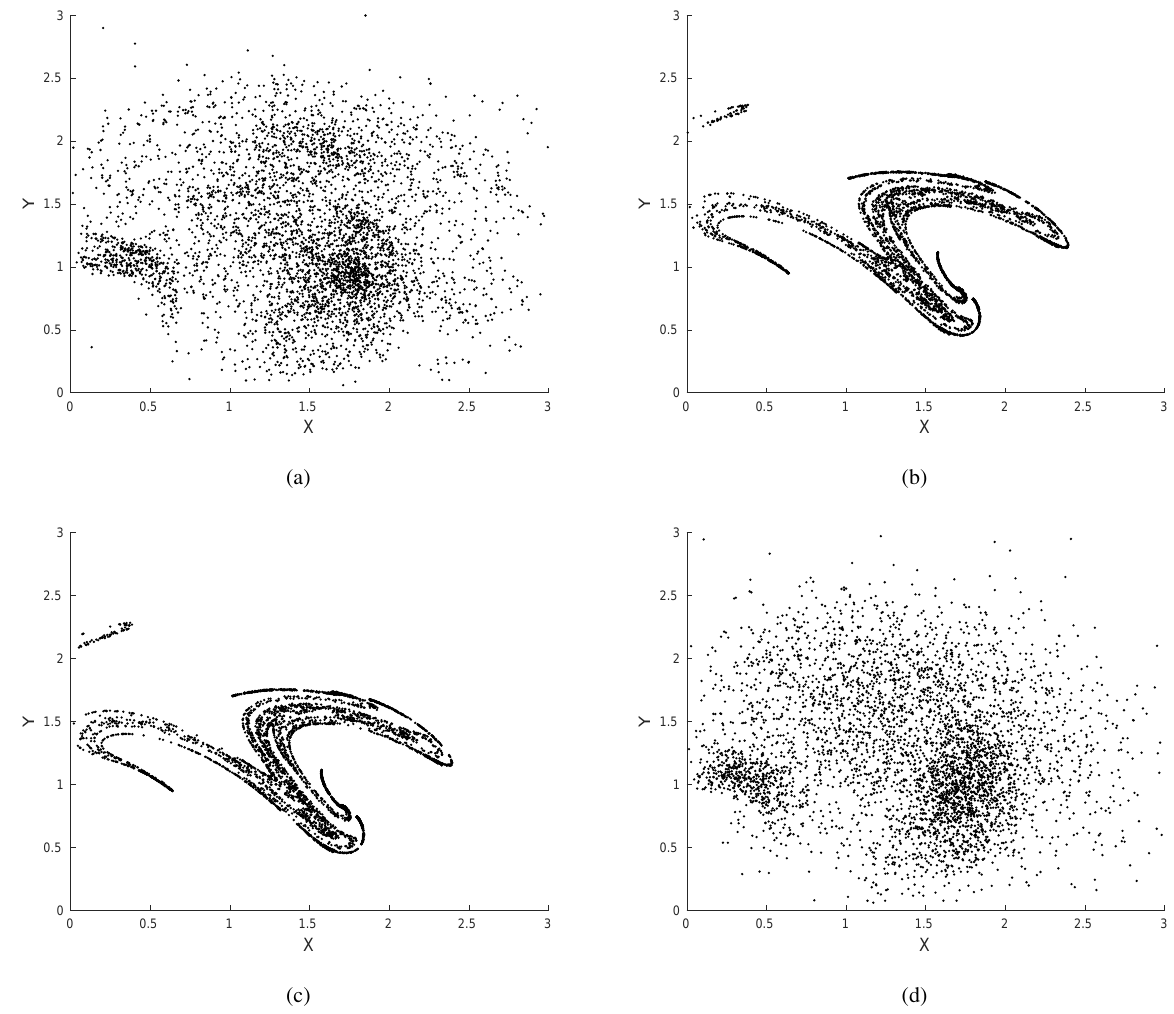
Figure 8. Poincaré section in Z = 0 of (a) coupled model, (b) uncoupled model, (c) 1st order parametrization, and (d) 2nd order parametriza- tion. For case τ = 1 , the Lorenz 63 model acts as a slow forcing on the Lorenz 84 6